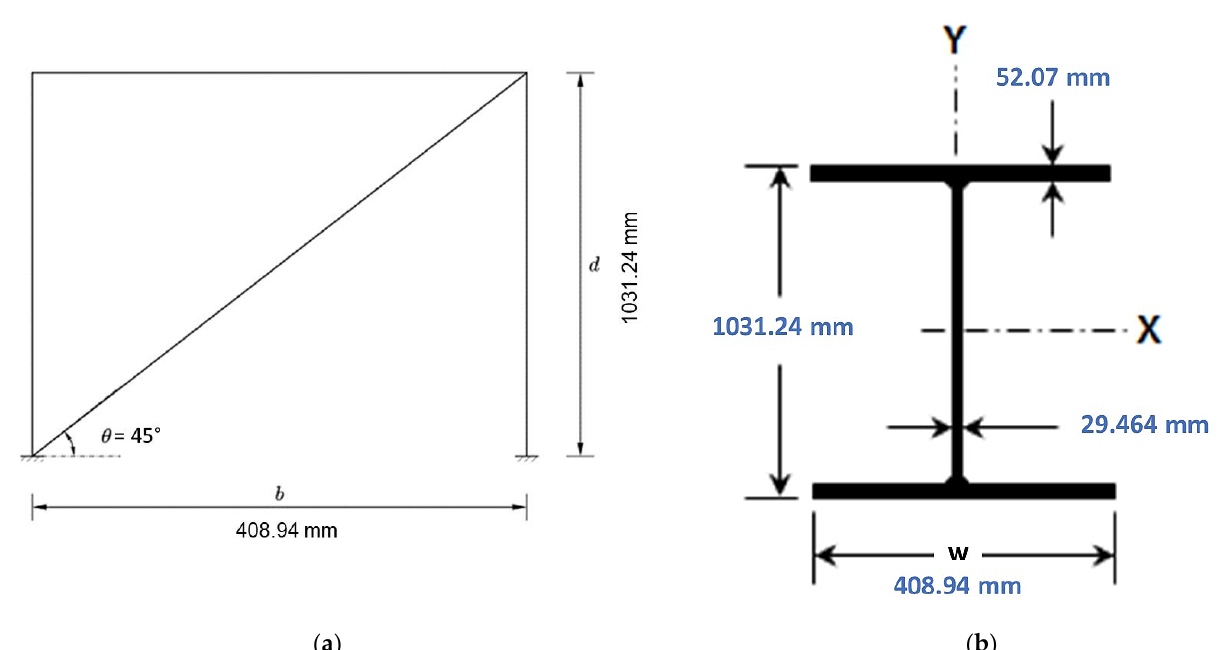
Figure 5. ( a ) A simplified model with a depth of 40.6 inches, flange width of 16.1 inches, flange thickness of 2.05 inches, web thickness of 1.16 inches, and area of 109 inches 2 , respectively. ( b ) Model structure beam and column with cross-sectional dimensions.